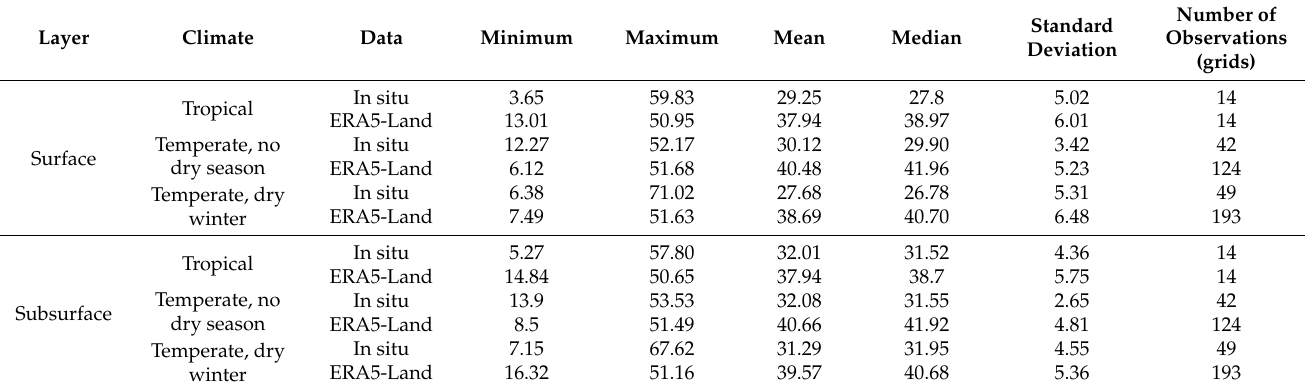
Table 1. Statistical characteristics of the surface and subsurface soil moisture (% by volume) of different climate zones. Layer Climate Data